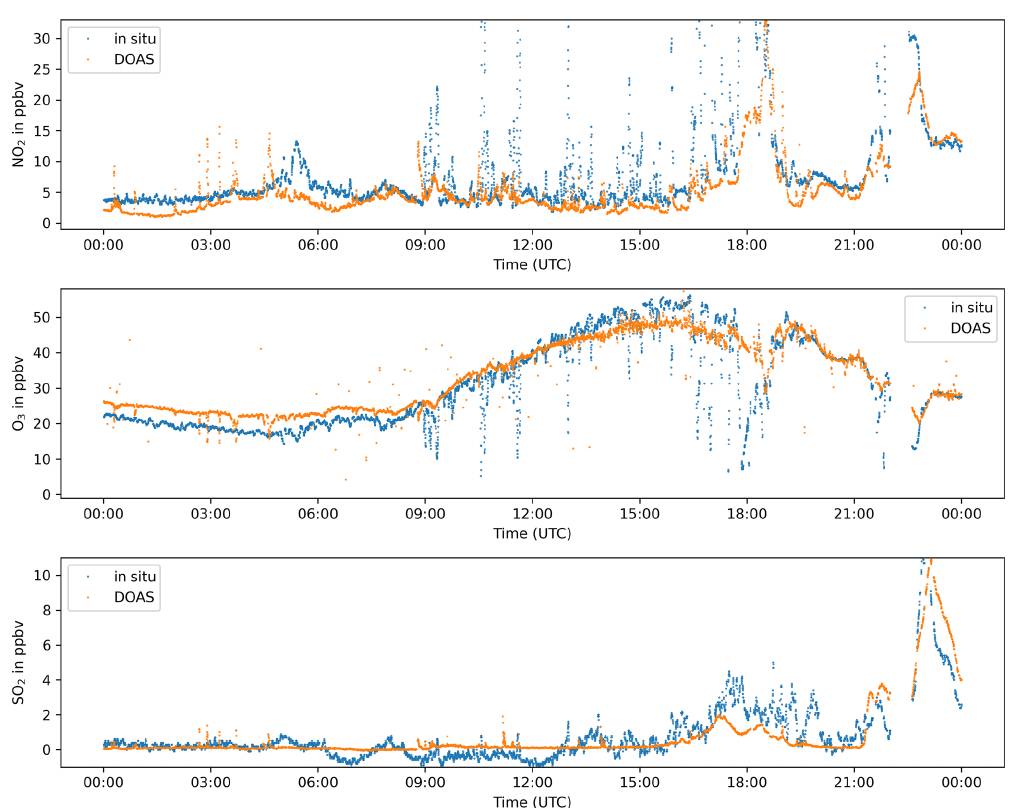
Figure 3. Time series of NO 2 , O 3 and SO 2 measured by the in situ instruments (blue) and the LP-DOAS (orange) on 20 July